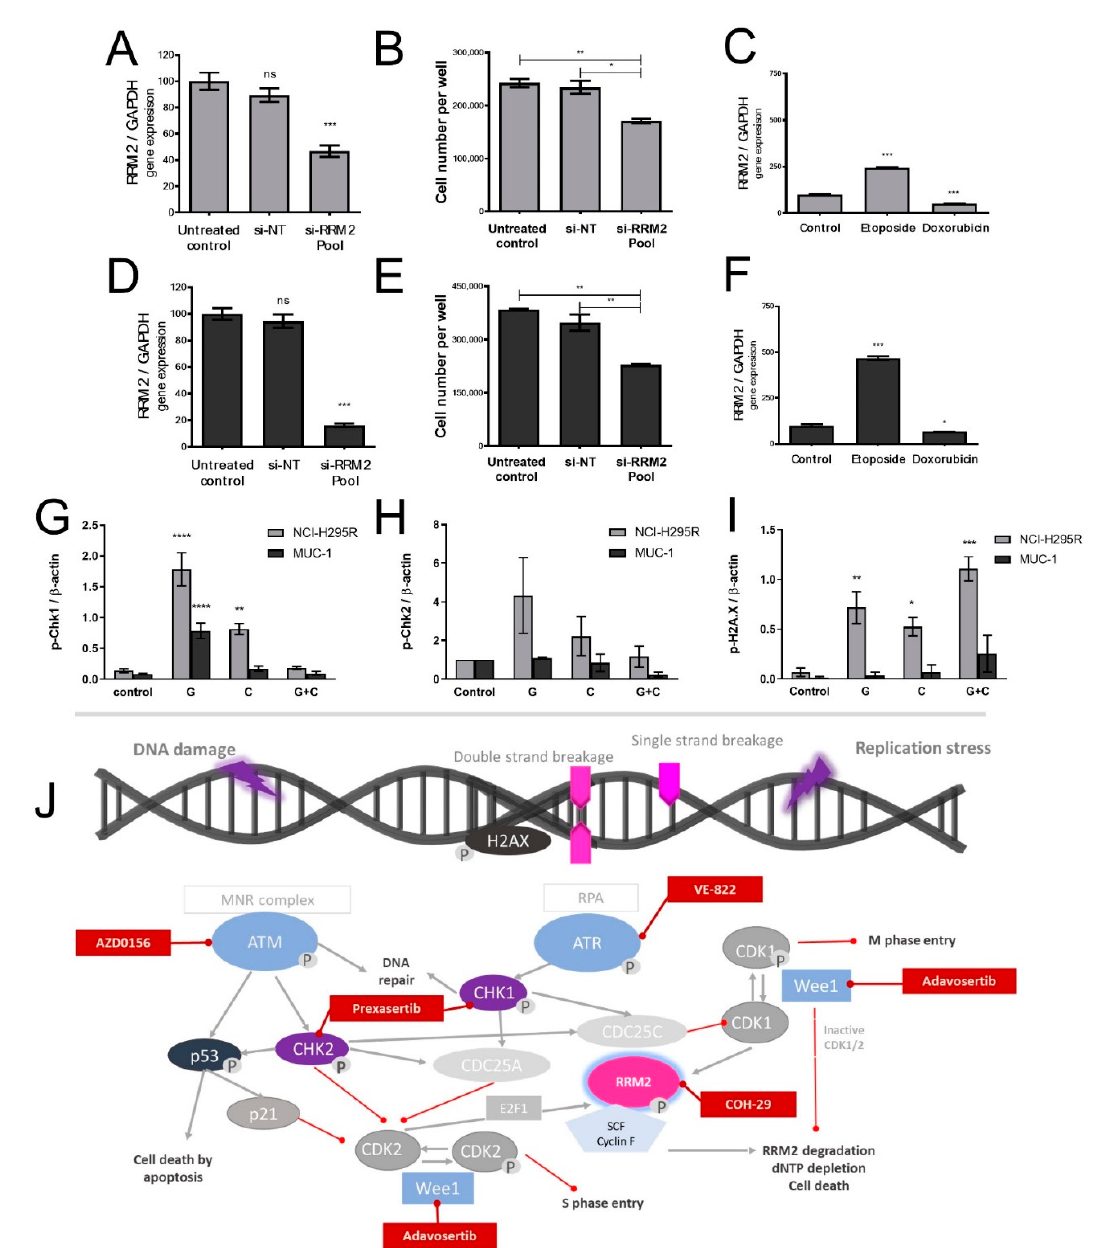
Figure 5. Real-time PCR analysis of RRM2 ( A , D ) gene expression and number of surviving cells ( B , E ) under RRM2 siRNA knockdown for NCI-H295R and MUC-1, respectively. RRM2 gene expression upon etoposide and doxorubicin treatment for NCI-H295R and MUC-1 ( C , F ). Quantification of Western blots for p-Chk1 ( G ), p-Chk2 ( H ), and p-H2AX ( I ) for no treatment, gemcitabine, cisplatin, and combination of both (gemcitabine and cisplatin) 24 h after treatment. Schematic illustration of the related DNA damage–repair pathway, including relevant therapeutic inhibitors ( J ). Stars represent significance vs. nontreated (*, p < 0.05; **, p < 0.01; ***, p < 0.001; ****, p < 0.0001); ns,